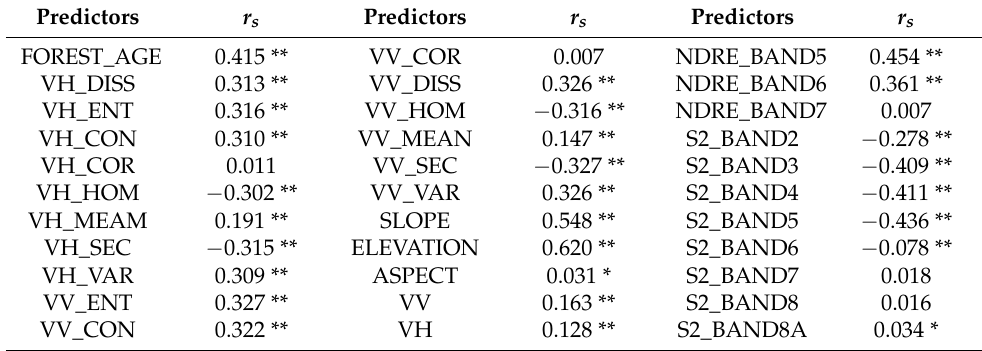
Table 3. r s of predictors and canopy height at sample scale.